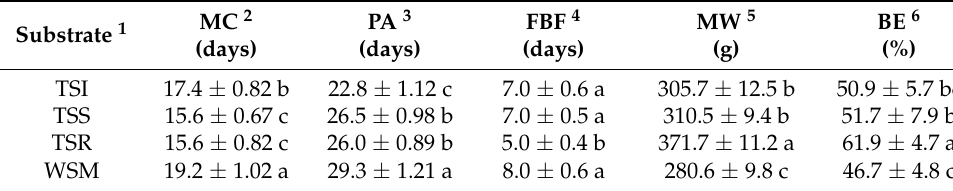
Table 4. Influence of different substrates containing cardunculus residues on fruiting bodies yield and production